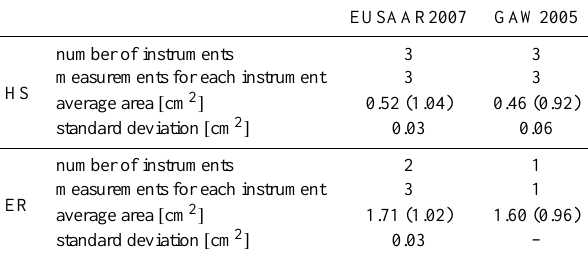
Table 8. Measured Aethalometer spot areas. HS and ER refer to models with “high sensitivity” and “extended range” spots with nominal spot area 0.5cm 2 and 1.67cm 2 , respectively. The ratio of measured and reference spot area is given between